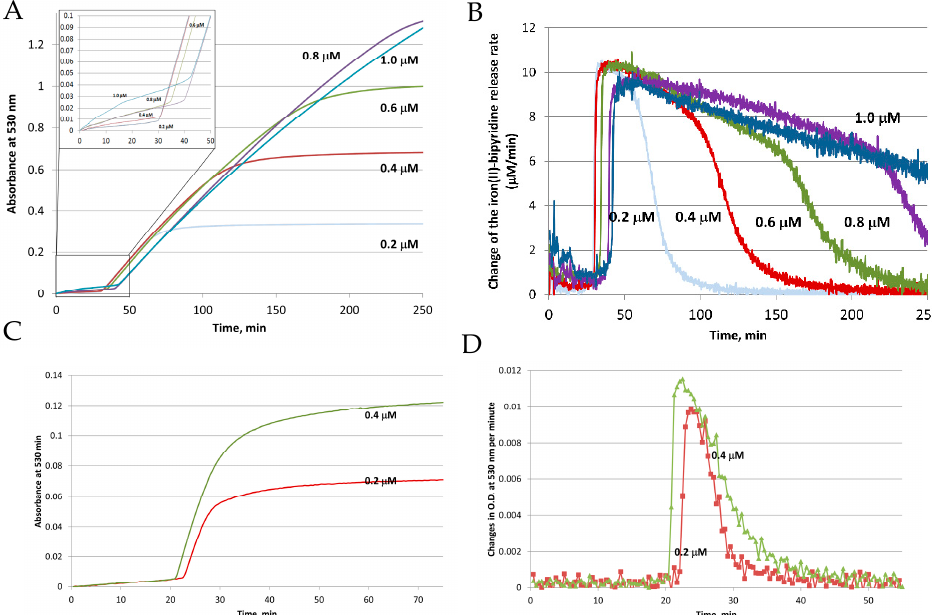
Figure 3. Reductive mobilization of iron from HosF containing 2250 Fe/shell. Conditions: 0.2–1 µ M ferritin, 2 mM NADH, 200 µ M FMN, 2 mM 2,2 (cid:48) -bipyridine, 2650 U/mL catalase, at pH 7.0 and 22 ◦ C. ( A ) Absorbance change of [Fe(bipy) 3 ] 2+ as a function of time. ( B ) Change of the iron(II)–bipyridine release rate versus time for different concentrations of HosF. ( C , D ) Reductive mobilization of iron from human recombinant heteropolymer ferritin (0.2 and 0.4 µ M) loaded with 500 Fe/protein, in the presence of 2 mM NADH, 200 µ M FMN, 2 mM 2,2 (cid:48) -bipyridine, 2650 U/mL catalase, at pH 7.0 and 28 ◦ C. ( C ) Absorbance change of [Fe(bipy) 3 ] 2+ as a function of time. ( D ) Change of the iron(II)–bipyridine release rate versus time, for different concentrations of heteropolymer ferritin. Reprinted with permission from Ref.